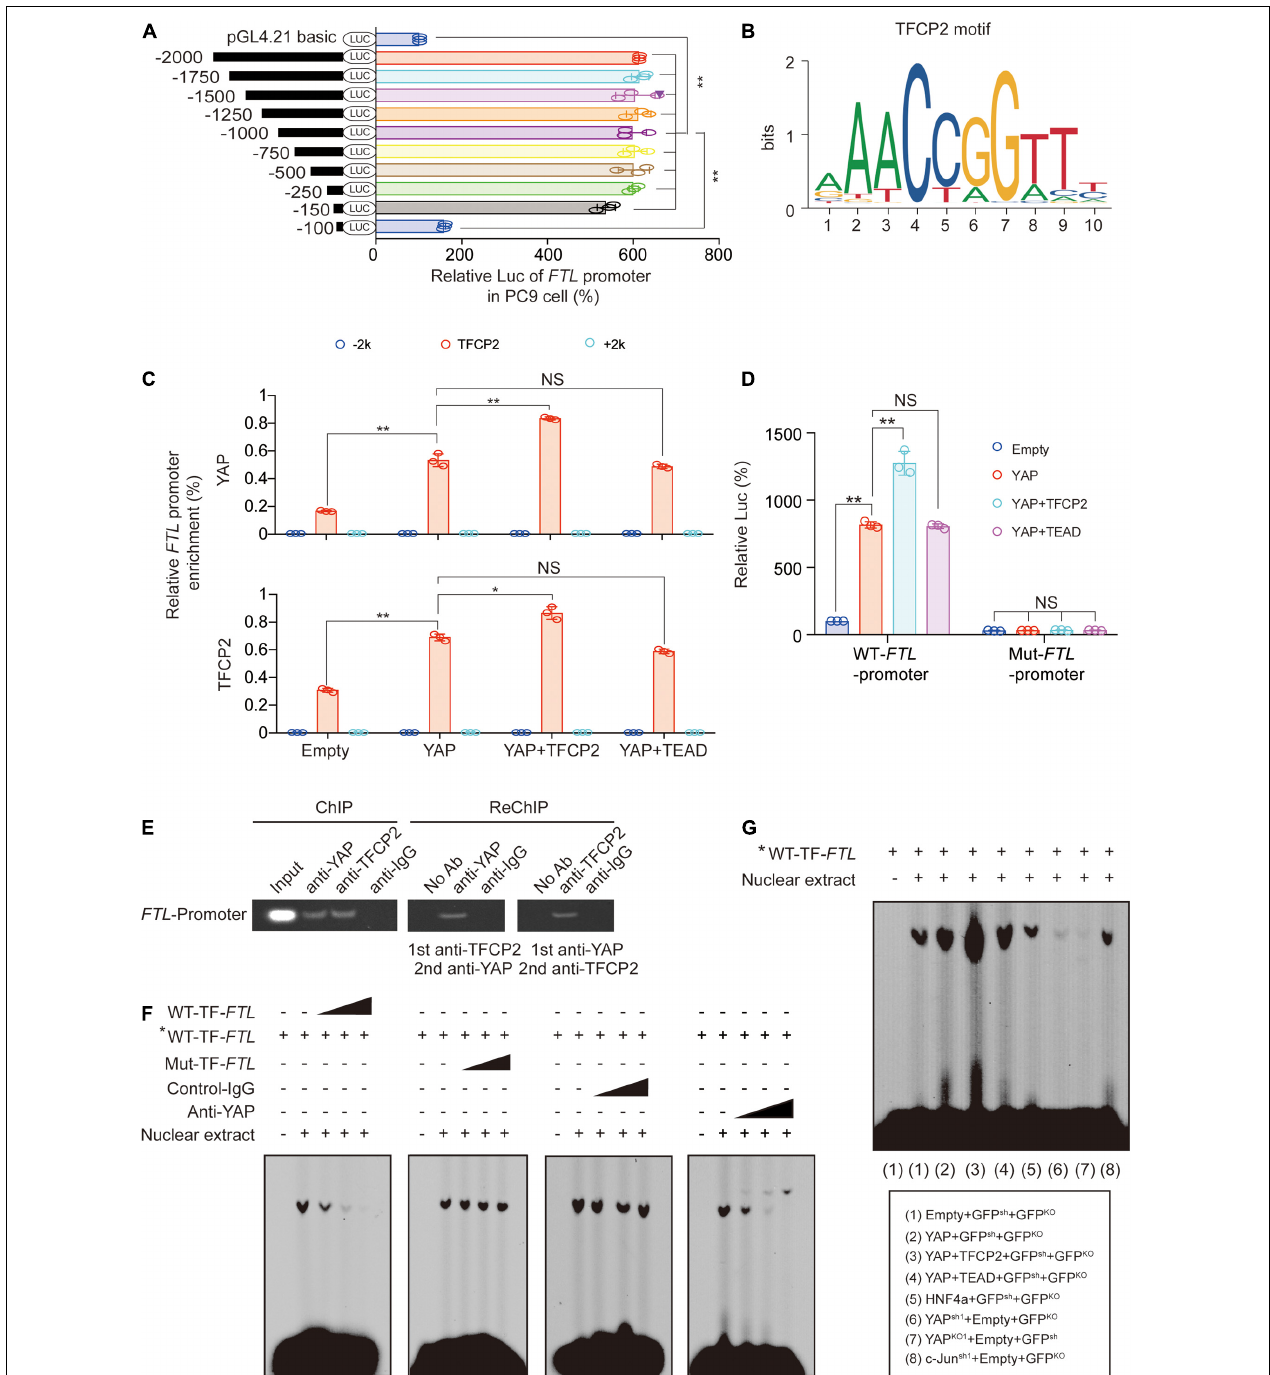
FIGURE 3 | Transcriptions of FTL are stimulated by YAP via TFCP2. (A) The indicated regions of FTL promoter Luc activity measured in PC9 cells. (B) The TFCP2 motif was searched using the JASPAR database. (C) Enrichment of YAP and TFCP2 at the indicated region around the FTL promoters in control cells and PC9 cells overexpressing YAP with TFCP2 or TEAD. (D) Wild type (WT) or mutant (Mut) FTL promoter Luc activity measured in control cells and PC9 cells overexpressing YAP with TFCP2 or TEAD. (E) Co-occupancy of YAP and TFCP2 in FTL promoters measured by ChIP and Re-ChIP assays using anti-YAP or anti-TFCP2 antibodies in PC9 cells. (F) Nuclear extracts from PC9 cells were incubated with WT- or Mut-TF- FTL (the TFCP2 motif was mutated in FTL ) probes with or without the presence of control-IgG or anti-YAP antibodies. The asterisk indicates probes labeled with biotin. The DNA-protein interactions were measured using EMSA. (G) Nuclear extracts from PC9 cells with the indicated genes overexpression, knockdown or knockout were incubated with biotin-labeled WT-TF- FTL . The DNA-protein interactions were measured using EMSA. The data are shown as the mean ± SD from three biological replicates (including IB). * P < 0.05, ** P < 0.01 indicates statistical significance. Data in (A,C,D) were analyzed using a one-way ANOVA